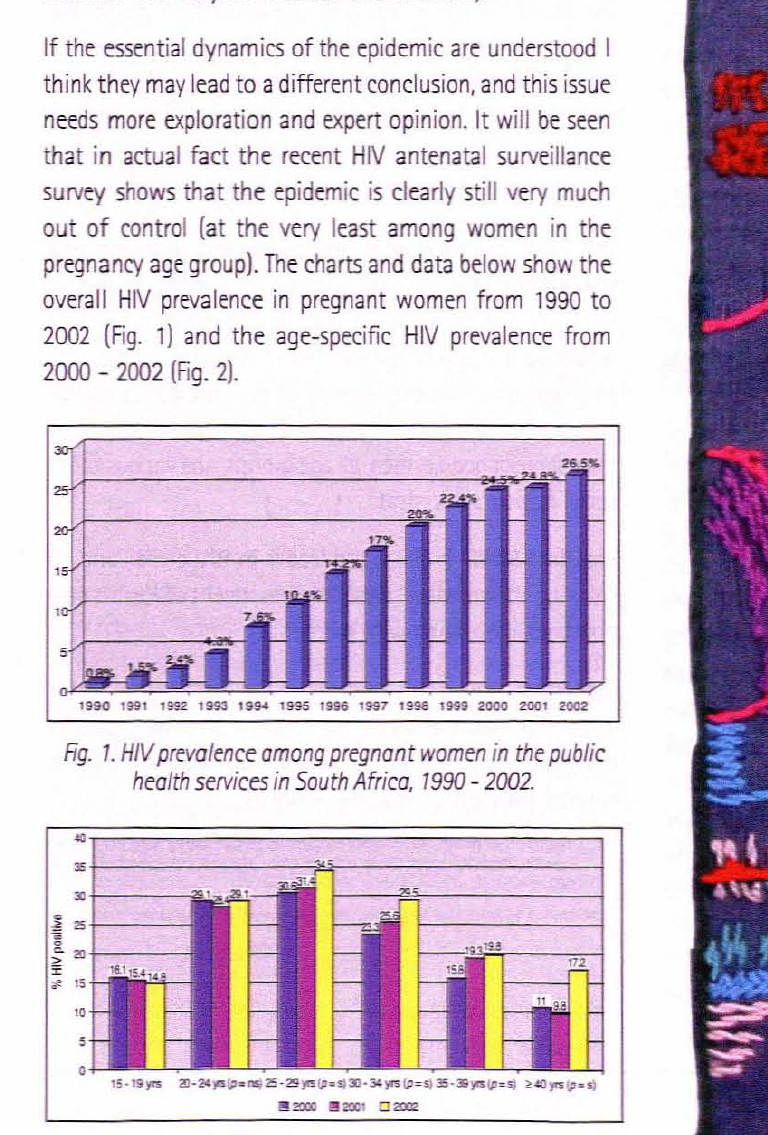
Fig. 2. Age-specific HIVprevalence amang pregnant wamen in the pUblic health services in Sauth Africa, 2000 - 2002.